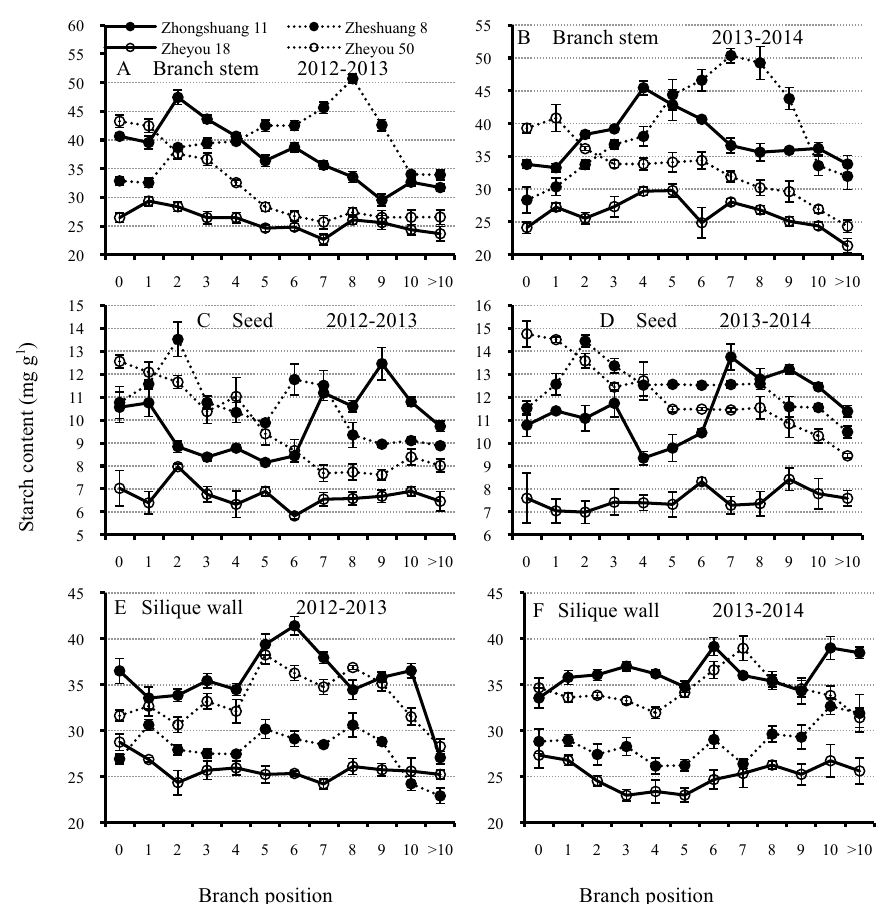
Fig. 5: Starch content in the main inflorescence and different branches from the top to the bottom of the main stem in the branch stem in (A) 2012-2013 and (B) 2013-2014, seed in (C) 2012-2013 and (D) 2013-2014, and silique wall in (E) 2012-2013 and (F) 2013-2014 growth seasons in the four cultivars, Zheyou 50, Zhongshuang 11, Zheyou 18, and Zheshuang